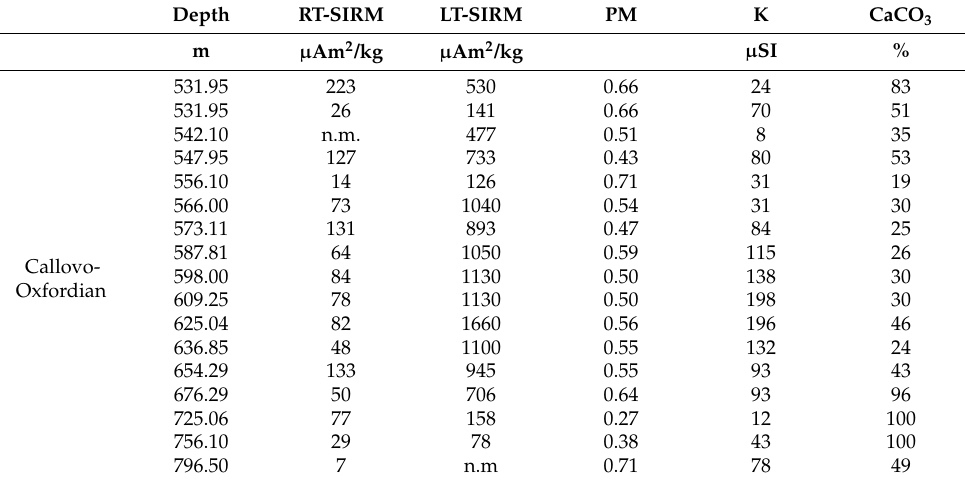
CaCO 3 : carbonate